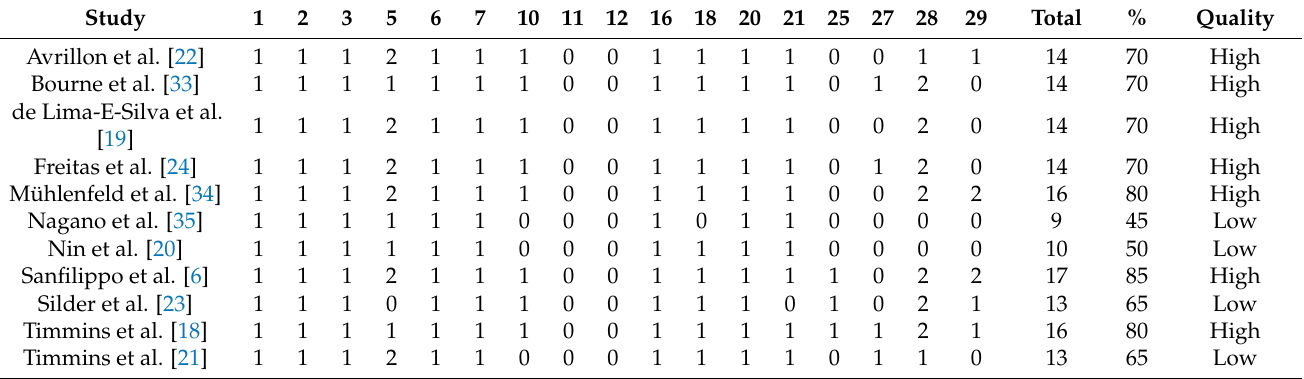
Table 1. Risk of bias assessment.